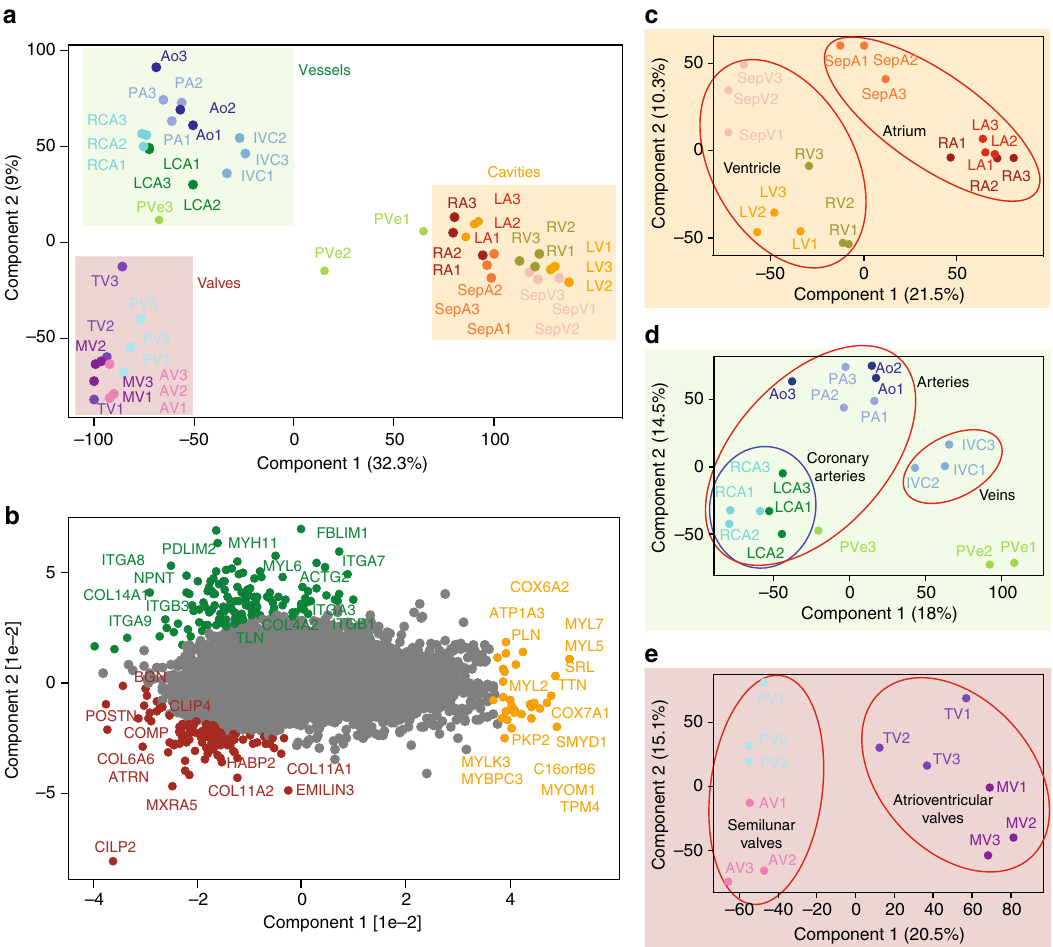
Fig. 2 Principal component analysis (PCA) of the 16 heart regions based on their proteomic expression pro fi les. a The proteomes of the cavities (RA, LA, RV, LV, SepA, and SepV), vessels (Ao, PA, RCA, LCA, IVC, and PVe), and valves (TV, MV, AV, and PV) depicted by replicate number (individuals 1, 2, and 3). The fi rst and second component segregate the heart areas and account for 32.3 and 9% of the variability, respectively. b Proteins driving the segregation between the three heart areas. c Cavities segregate into the ventricular and atrial part, d vessels into coronary arteries (RCA, LCA) and outgoing vessels (Ao, PA), and e valves into ventricular (MV, TV) and semilunar valves (AV, between heart regions, suggest functional differences, and pin- point potential cell-type markers. To illustrate the usefulness of the heart proteomic map, we apply it to de fi ne molecular changes in patients suffering from atrial fi brillation (AFib).